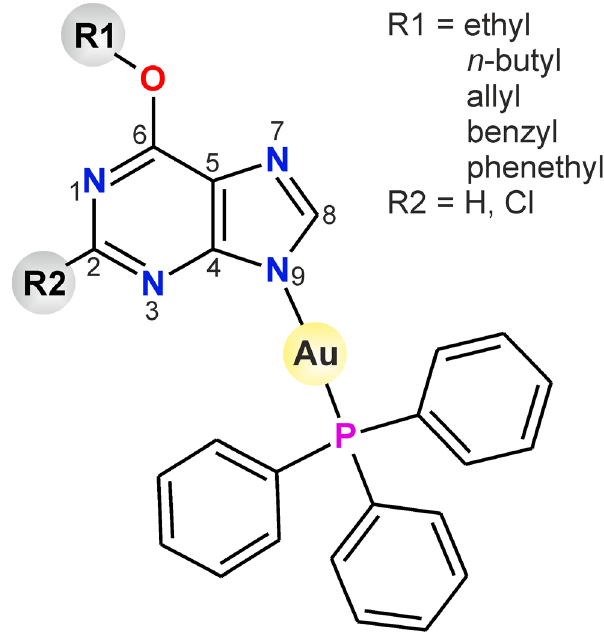
Figure 2. Schematic representation of the prepared gold(I) complexes